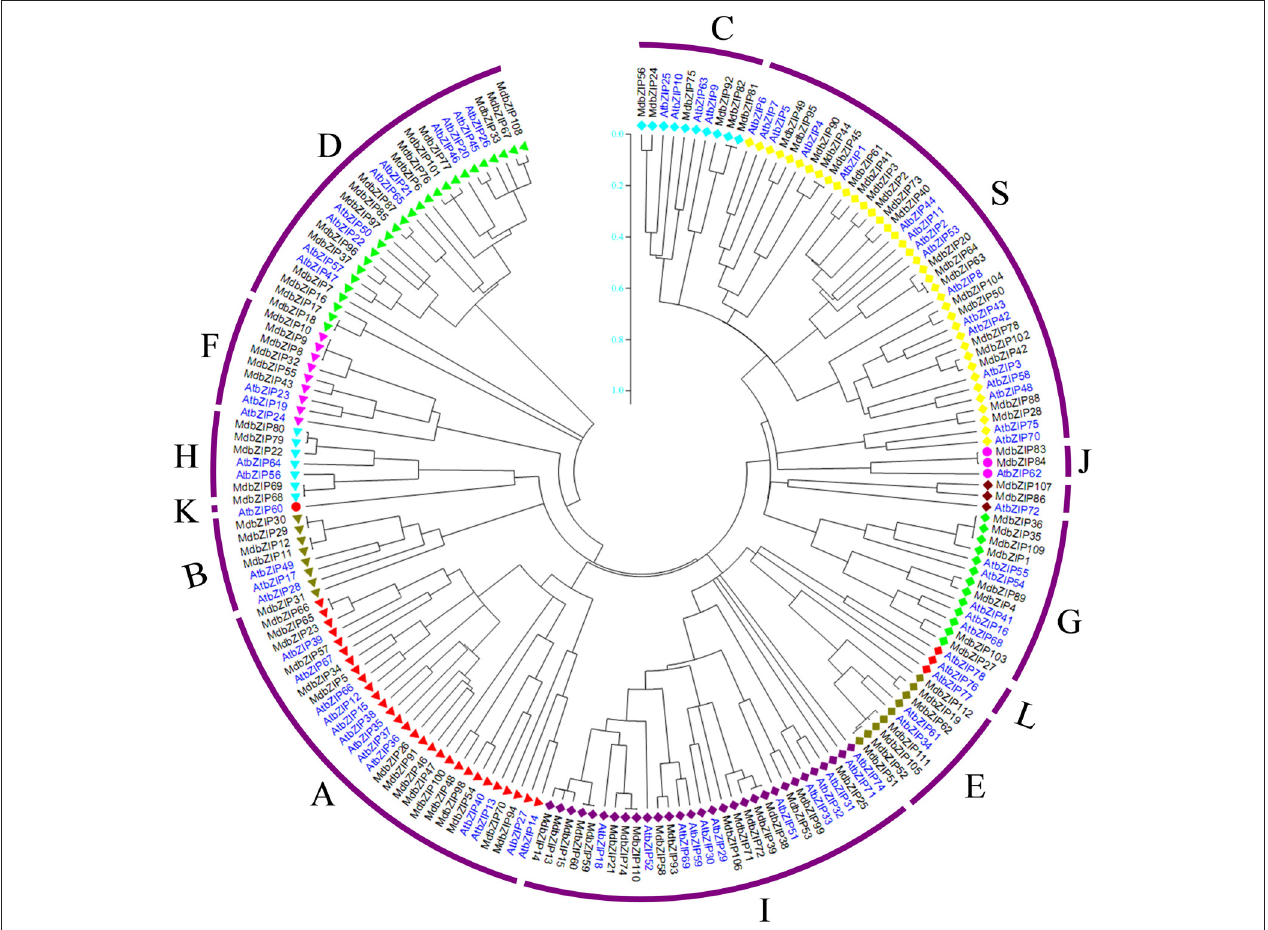
FIGURE 5 | Phylogenetic analysis (Neighbor joining tree) of apple (black) and Arabidopsis thaliana (blue) bZIP proteins.